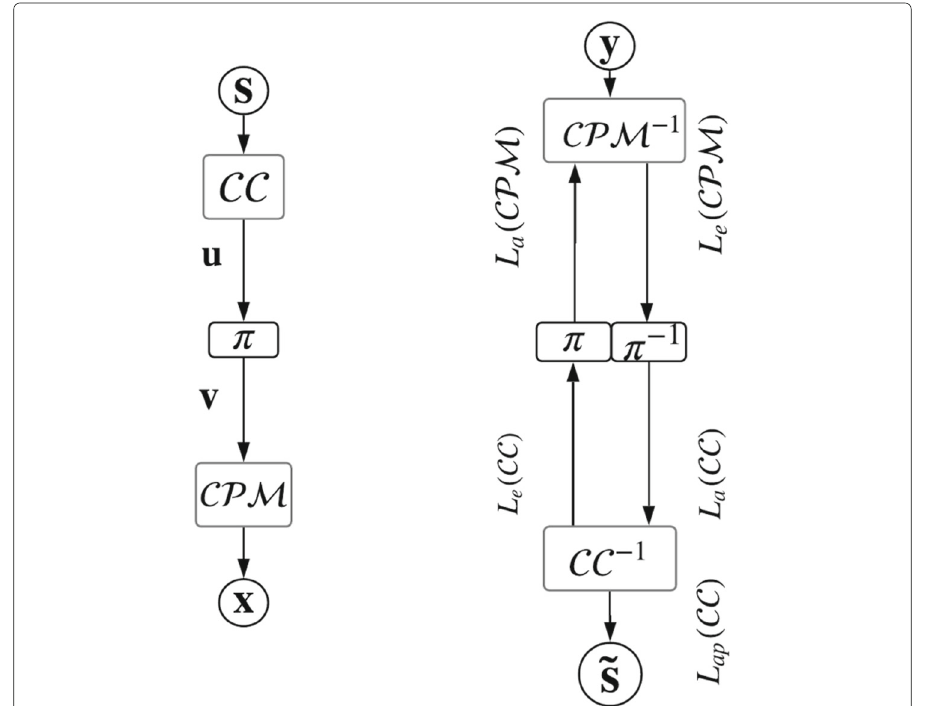
Fig. 4 The vectorized (proto) graph corresponding to the C-CPM transmitter (left) and receiver